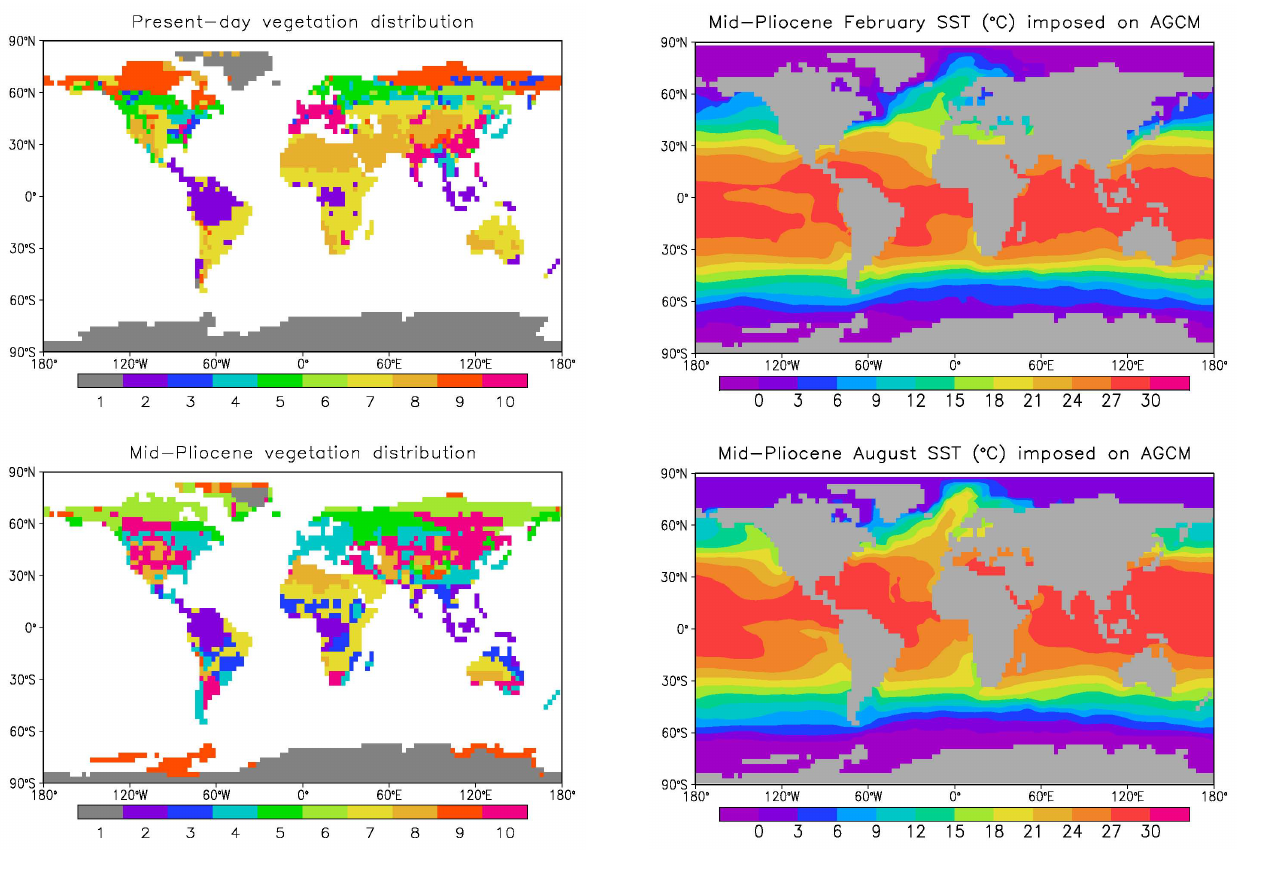
Fig. 3. Surface index denoting land vegetation in the present day (top figure) and in the mid-Pliocene (bottom figure). Key: (1) con- tinental ice, (2) broadleaf evergreen forest, (3) broadleaf decidu- ous forest and woodland, (4) mixed coniferous, broadleaf deciduous forest and woodland, (5) coniferous forest and woodland, (6) high latitude deciduous forest and woodland, (7) wooded C4 grassland, (8) shrubs and bare ground, (9) tundra, (10) C3 grassland.